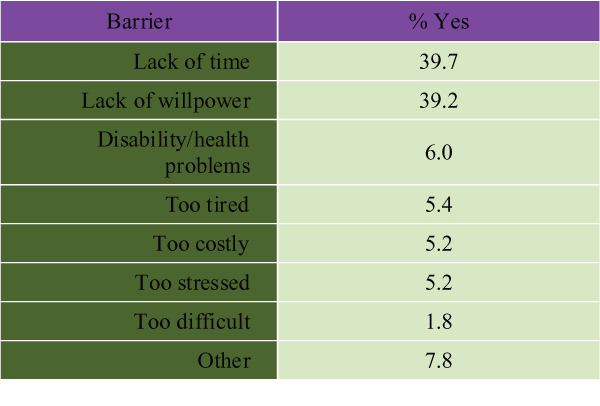
Barriers to Health Improvement Reported by Canadian Women Source: Statistics Canada, NPHS, 1996–1997